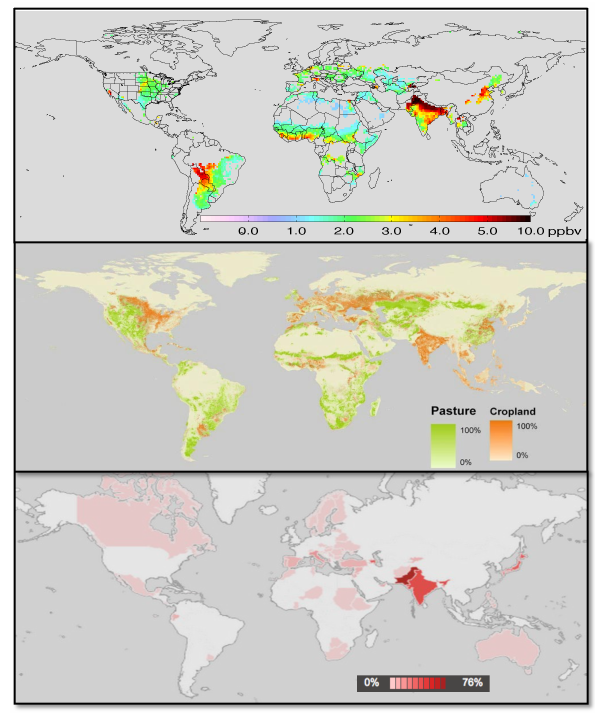
Figure 6. (top panel) The NH 3 VMRs from the persistent sources filtered with the collocated occurrences of elevated concentrations ( ≥ 1.4ppbv) using a threshold of greater than 40 days; (mid- dle panel) pasture and Cropland Map (http://OurWorldInData.org); and (bottom panel) irrigated agricultural land areas (http://data. worldbank.org). Footnote: The World Bank provided the statement that the maps displayed on the World Bank web site are for refer- ence only and do not imply any judgment on the legal status of any territory, or any endorsement or acceptance of such